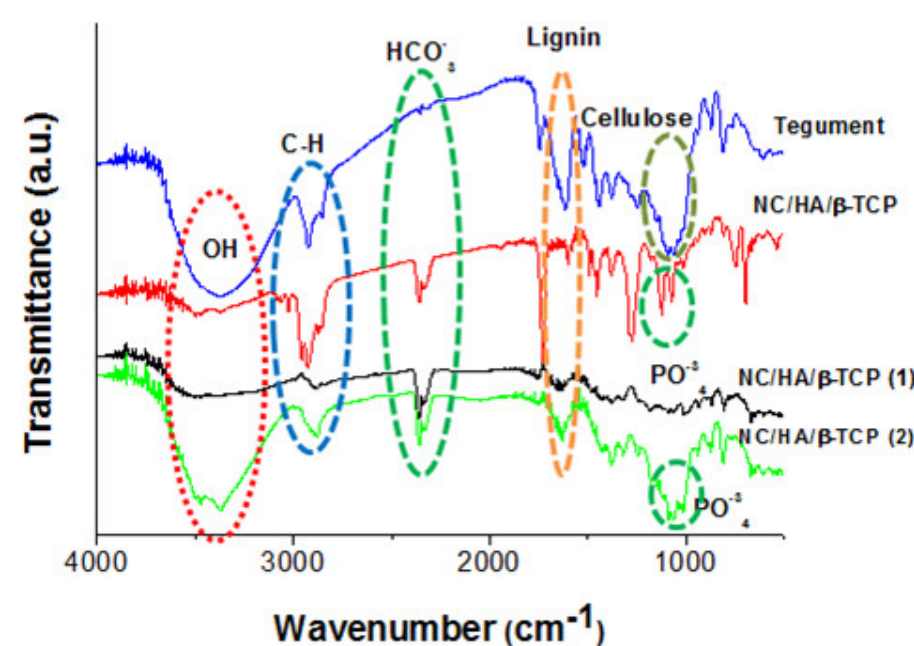
Figure 7. FTIR analysis of the source material (tegument) and the material obtained after extraction in three stages. FTIR obtained from tegument, NC/HA/β-TCP (immediately after hydrolysis), NC/HA/β-TCP (1) (30 days of hydrolysis), and NC/HA/β-TCP (2) (60 days of hydrolysis).